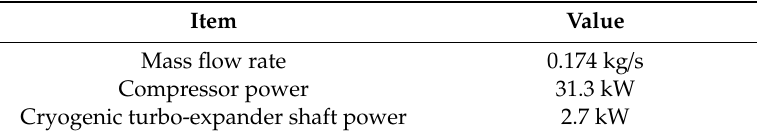
Table 3. Designed values for the reverse Brayton cryogenic